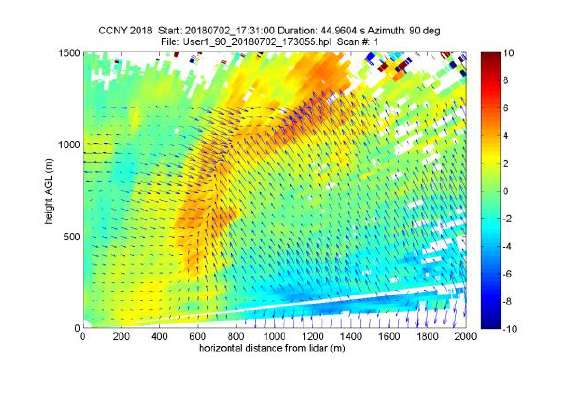
Fig. 7 Halo Streamline RHI output 13:30 EDT